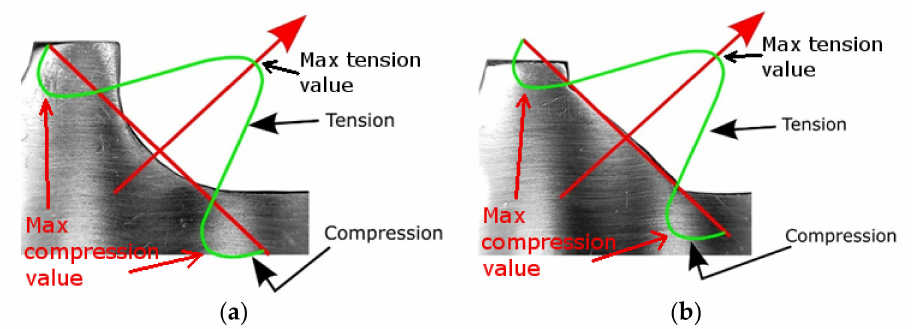
Figure 9. The distribution of residual stresses in the tested T-joints with fillet welds, where: ( a ) samples with concave welds, ( b ) samples with convex